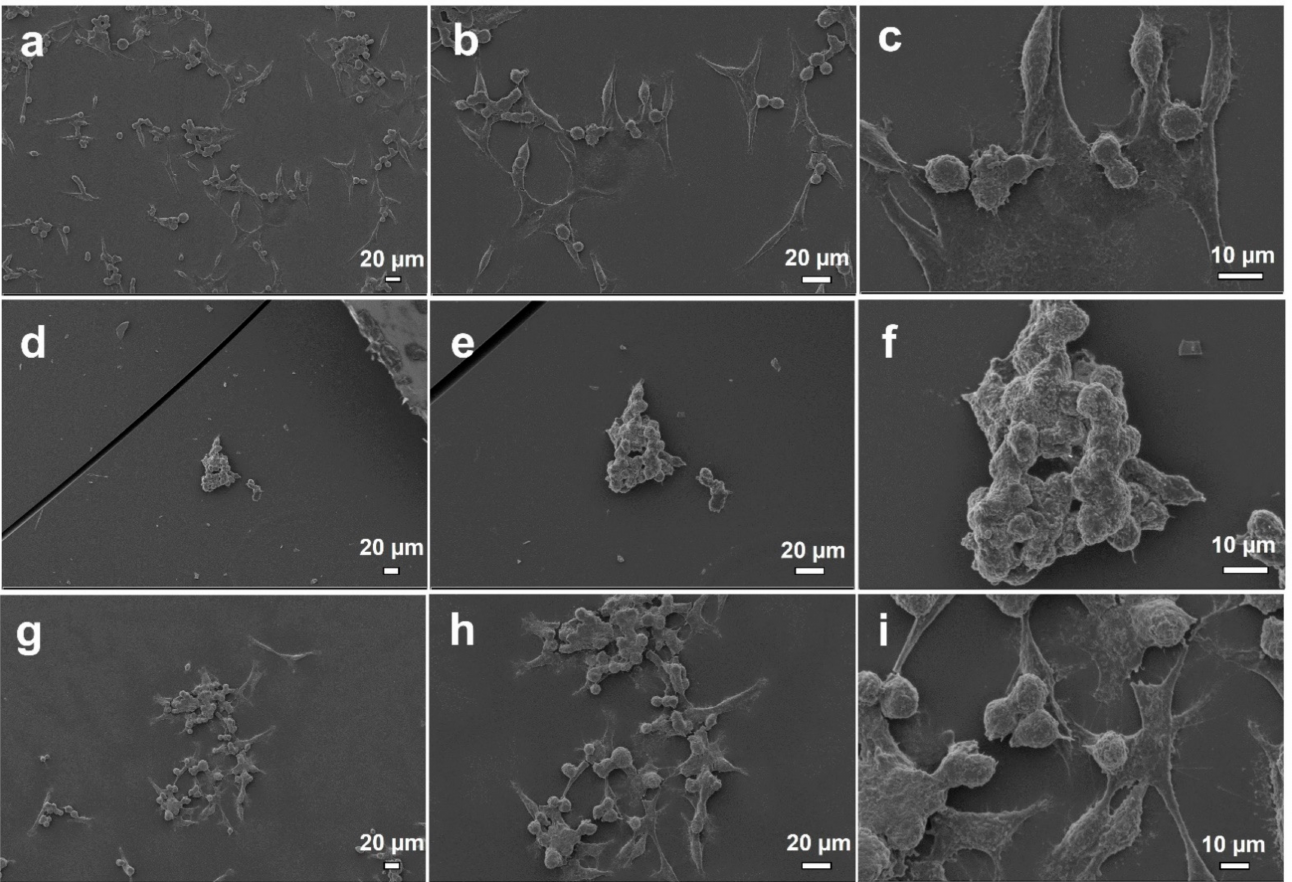
Figure 8. SEM images of PCS-201-012 cells adhesion after being cultivated with electrosprayed surfaces with different magnifications, ( a – c ) hHL, ( d – f ) hHL/0.05RS, ( g – i )